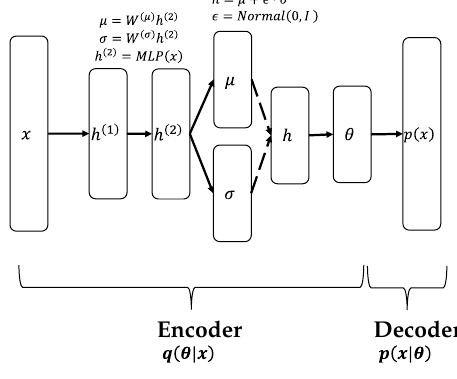
Figure 2. VAE base model Figure 3. WAE base model